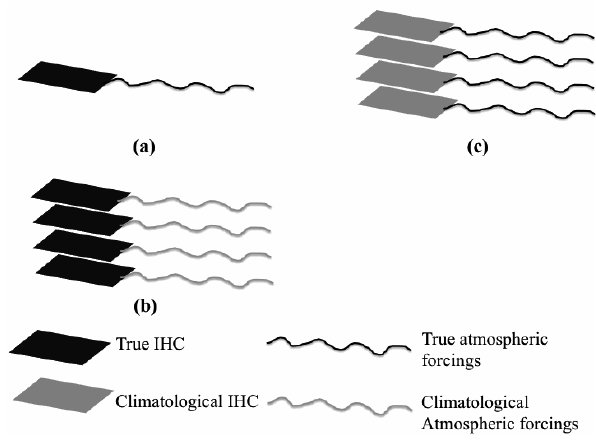
Fig. 2. Schematic diagram of (a) Observational analysis (b) ESP and (c)